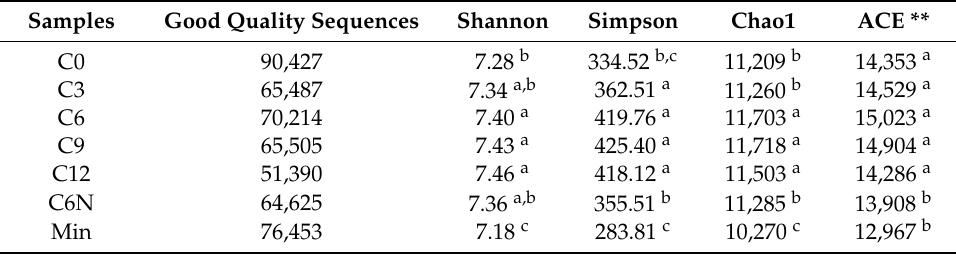
Table 2. Alpha-diversity indices of soil microbial communities under di ff erent treatments *.